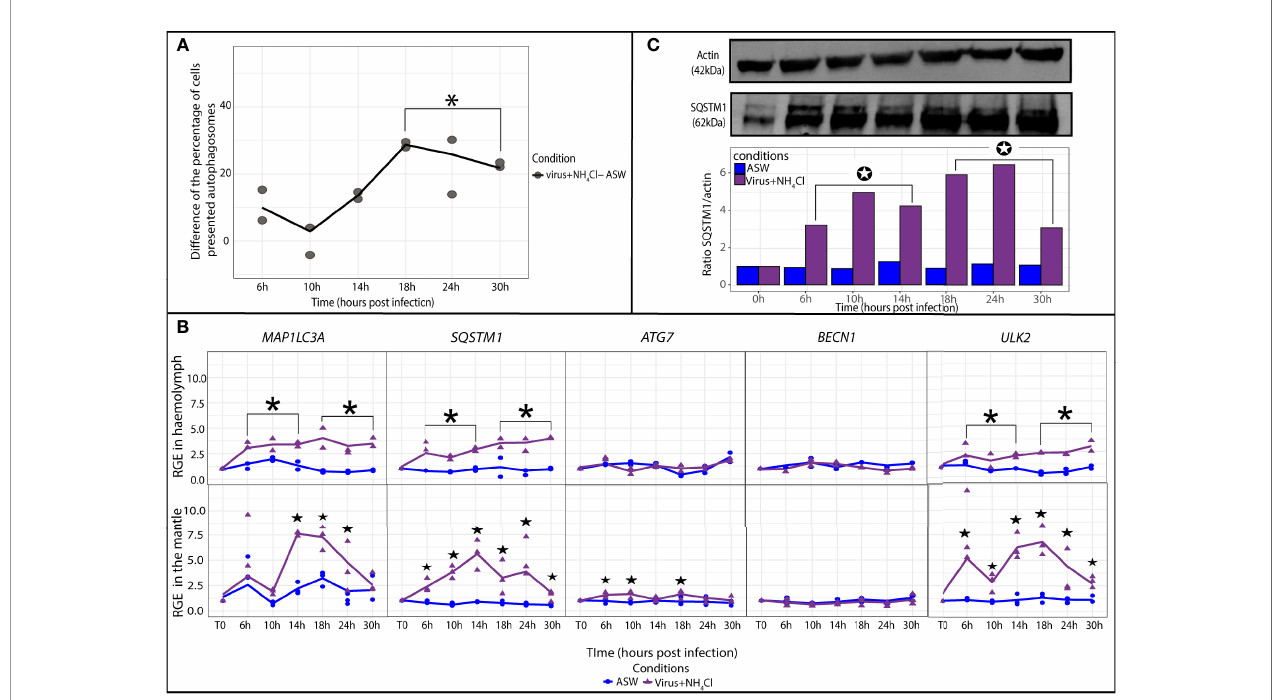
FIGURE 5 | Modulation of autophagy in Crassostrea gigas exposed to virus+NH 4 Cl. (A) Monitoring of autophagy in haemocytes of C. gigas by fl ow cytometry. Scatterplot of the difference of the percentage of haemocytes with autophagosomes between the seawater condition (ASW) and the virus+NH 4 Cl condition from 6 to 30 hpi (n=2 pools of 15 animals). The line represents the trend curve of the difference of percentage of cells between the two conditions. *Signi fi cant increase of the difference of the percentage of cells presented autophagosomes between the virus+NH 4 Cl and ASW condition between 18 to 30hpi (p < 0.05). (B) Relative gene expression of key autophagy genes in haemolymph and the mantle of the Paci fi c oysters, C. gigas , in seawater condition (blue) and the virus+NH 4 Cl condition (purple) at each sampling time point (T0, 6, 10, 14, 18, 24 and 30 hpi) detected by real time PCR (haemolymph: n=2 pools of 15 animals; mantle: n=3 animals). RGE, relative gene expression. The line represents the trend curve of the expression of each gene in the virus+NH 4 Cl condition (purple) and the ASW condition (blue). Signi fi cant difference between the virus+NH 4 Cl and ASW conditions at early (6-14 hpi) or late time points (18-30 hpi) of the experimental infection (p < 0.05). Signi fi cant difference between the virus+NH 4 Cl and ASW conditions of the same time point (p < 0.05). (C) Detection of the autophagy protein SQSTM1 in the mantle of C, gigas during the kinetic of infection by OsHV-1 in the virus+NH 4 Cl condition at each sampling time point (for each time point n=1 pool of 3 animals). Signi fi cant differences between the virus+NH 4 Cl and ASW condition at early (6-14 hpi) or late time points (18-30 hpi) of the experimental infection (p <